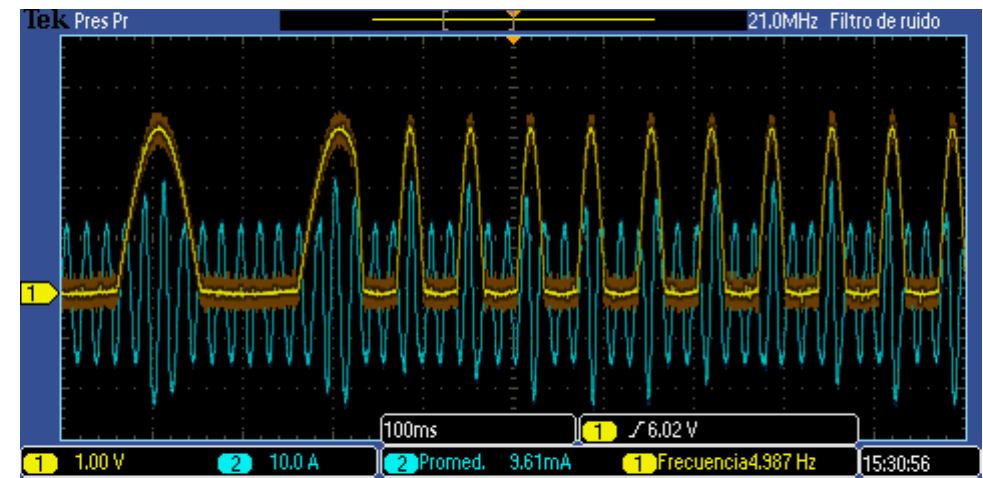
Figure 23. Motor current behavior after a sudden change in the pedaling frequency: 5 to 15 Hz.